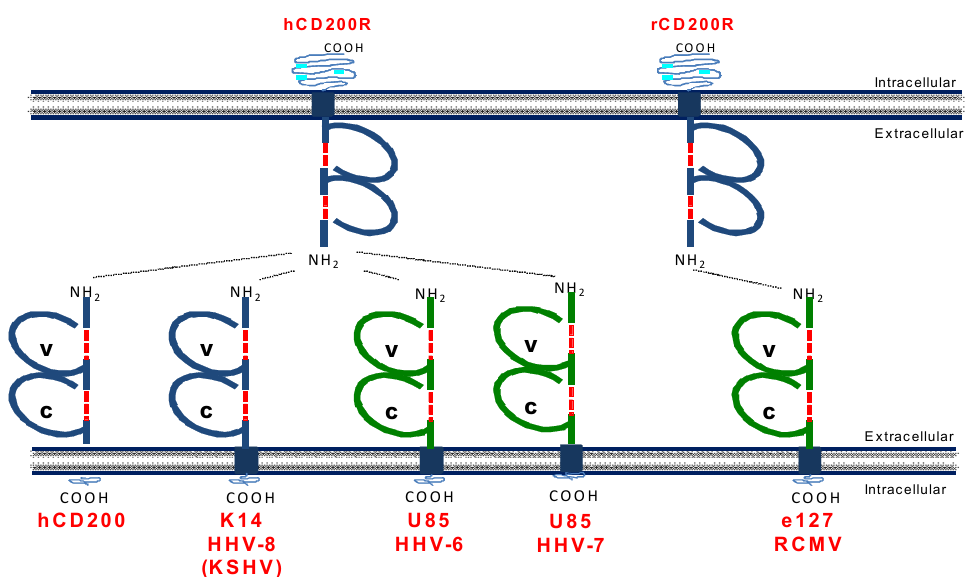
Figure 2. Determined structures of cellular CD200 and CD200 homologues encoded by human and rat herpesviruses. ‘V’ denotes a conserved variable-like Ig domain and ‘C’ denotes a conserved constant-like Ig domain. These domains are formed by disulfide binds which are denoted by a red broken line. Light blue portions of the intracellular domain of CD200R denotes tyrosine residues which can be phosphorylated during intracellular signalling. Dashed lines between receptor/ligands represent known interaction as detected in biochemical binding assays. Blue = structure known, Green = predicted structure based on homology to cellular CD200. Structural data was obtained from